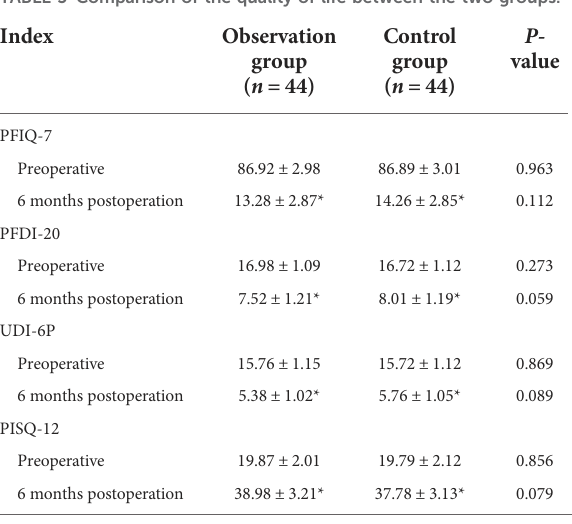
TABLE 5 Comparison of the quality of life between the two groups.